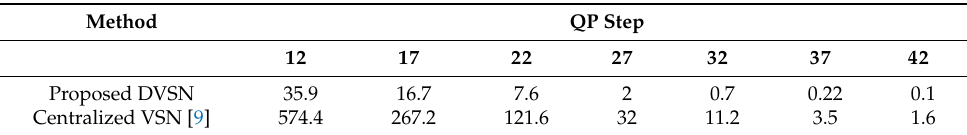
Table 5. Average video bitrate (Mbits/s) against